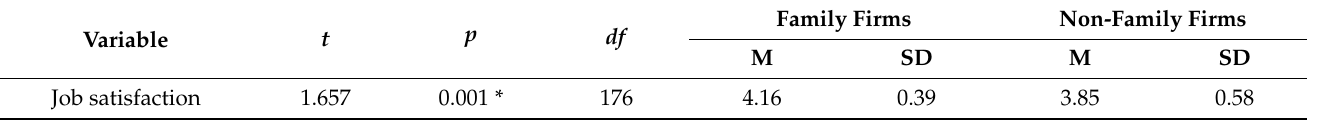
Table 4. t -Test: job satisfaction levels in family and non-family firms.